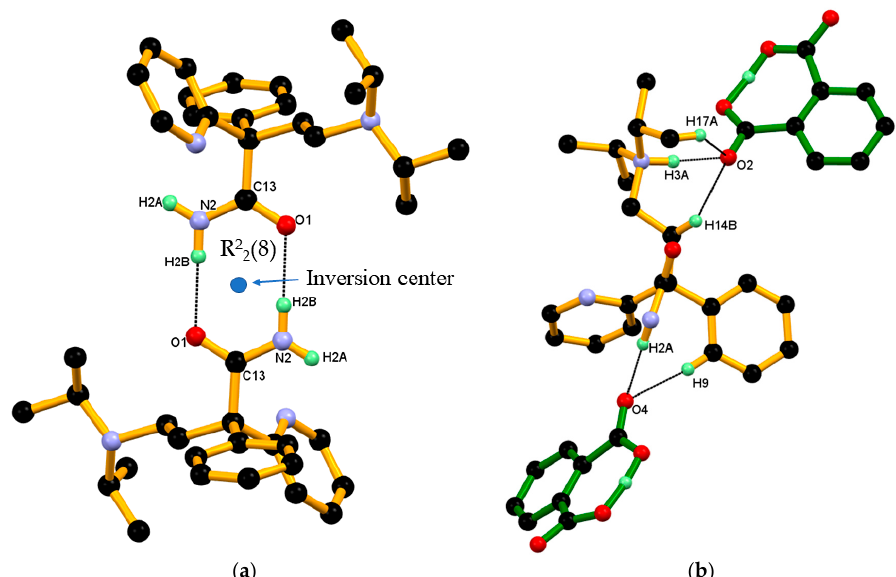
Figure 8. ( a ) Association between protonated DPA molecules through a pair of strong N–H ∙∙∙ O hydrogen bonds in R 22 (8) ring motif; and( b ) Association between the protonated DPA and PA¯ anions in DPA_PA salt, hereby protonated DPA molecules engaging both carboxylate and carboxyl groups of the PA¯ anion alternatively through a strong N–H ∙∙∙ O and charge assisted N + –H ∙∙∙ O¯ hydrogen bond and further supported by C–H ∙∙∙ O interaction.